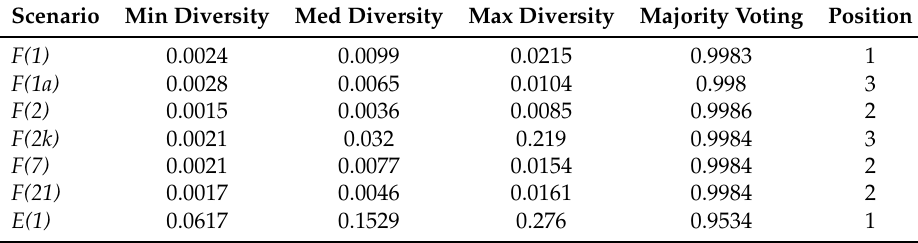
Table A2. The results of the ensemble learning experiment, assessing the feasibility of combining outputs of analyzed classifiers. The table presents the minimum, median and maximum diversity for all pairs of classifiers applied to every scenario, accuracy of majority voting and position of this accuracy score when compared to classifiers from Tables 1 and 2 (1—highest accuracy, 8—lowest